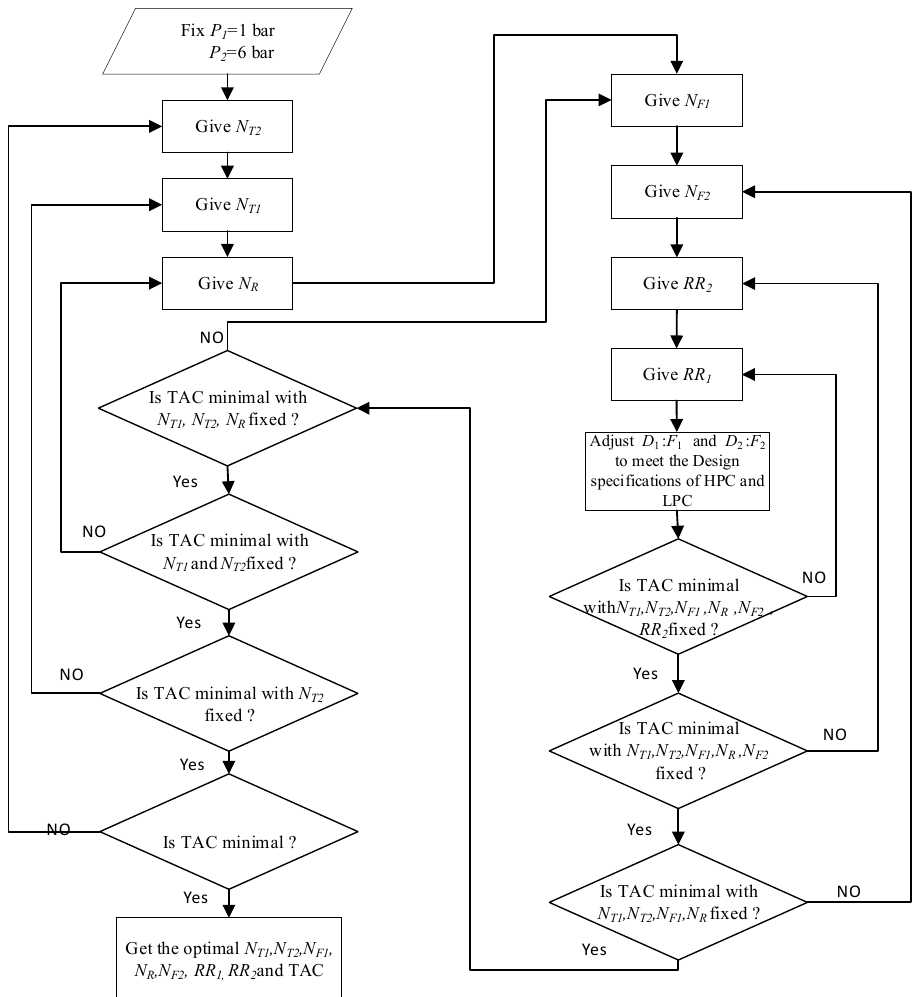
Figure 3. Sequential iterative optimization procedure for the partial HIPSD process.